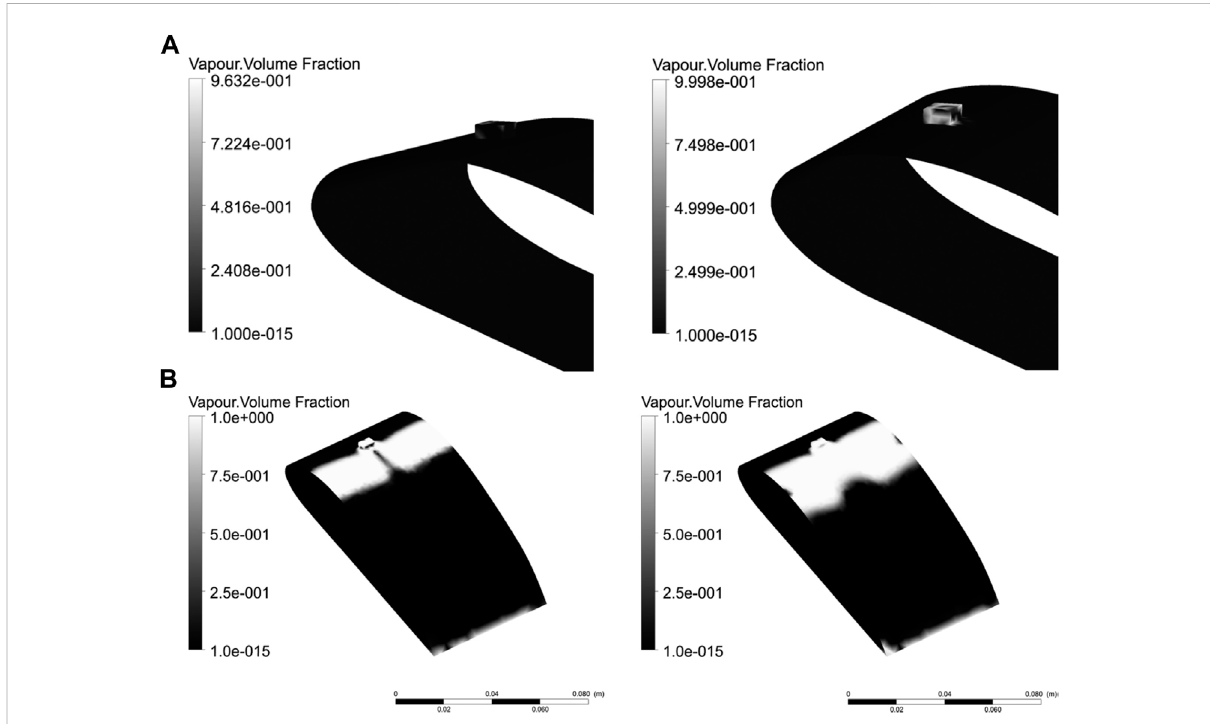
FIGURE 11 (A) Comparison of vapor volume fraction simulation without particles (left) and with particles (right ξ = 0.0032) at equal Δ p = 50.02 bars, Q i = 15 kg/s, and (B) comparison of vapor volume fraction simulation without particles (left) and with particles (right ξ = 0.0032, μ d = 0.87) at equal Δ p = 0.35 bars (Gregorc et al.,